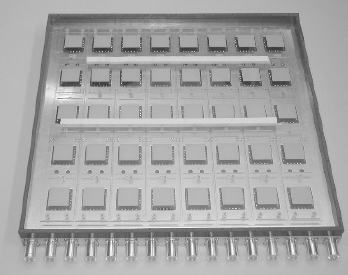
Figure 7: Eight-column dual polarized array developed by Pow- erwave Technologies Inc. Results are presented for this array in Section 5.3. Note that each vertical column of radiators forms an element with pattern (cid:2) a m ( θ ) in the horizontal